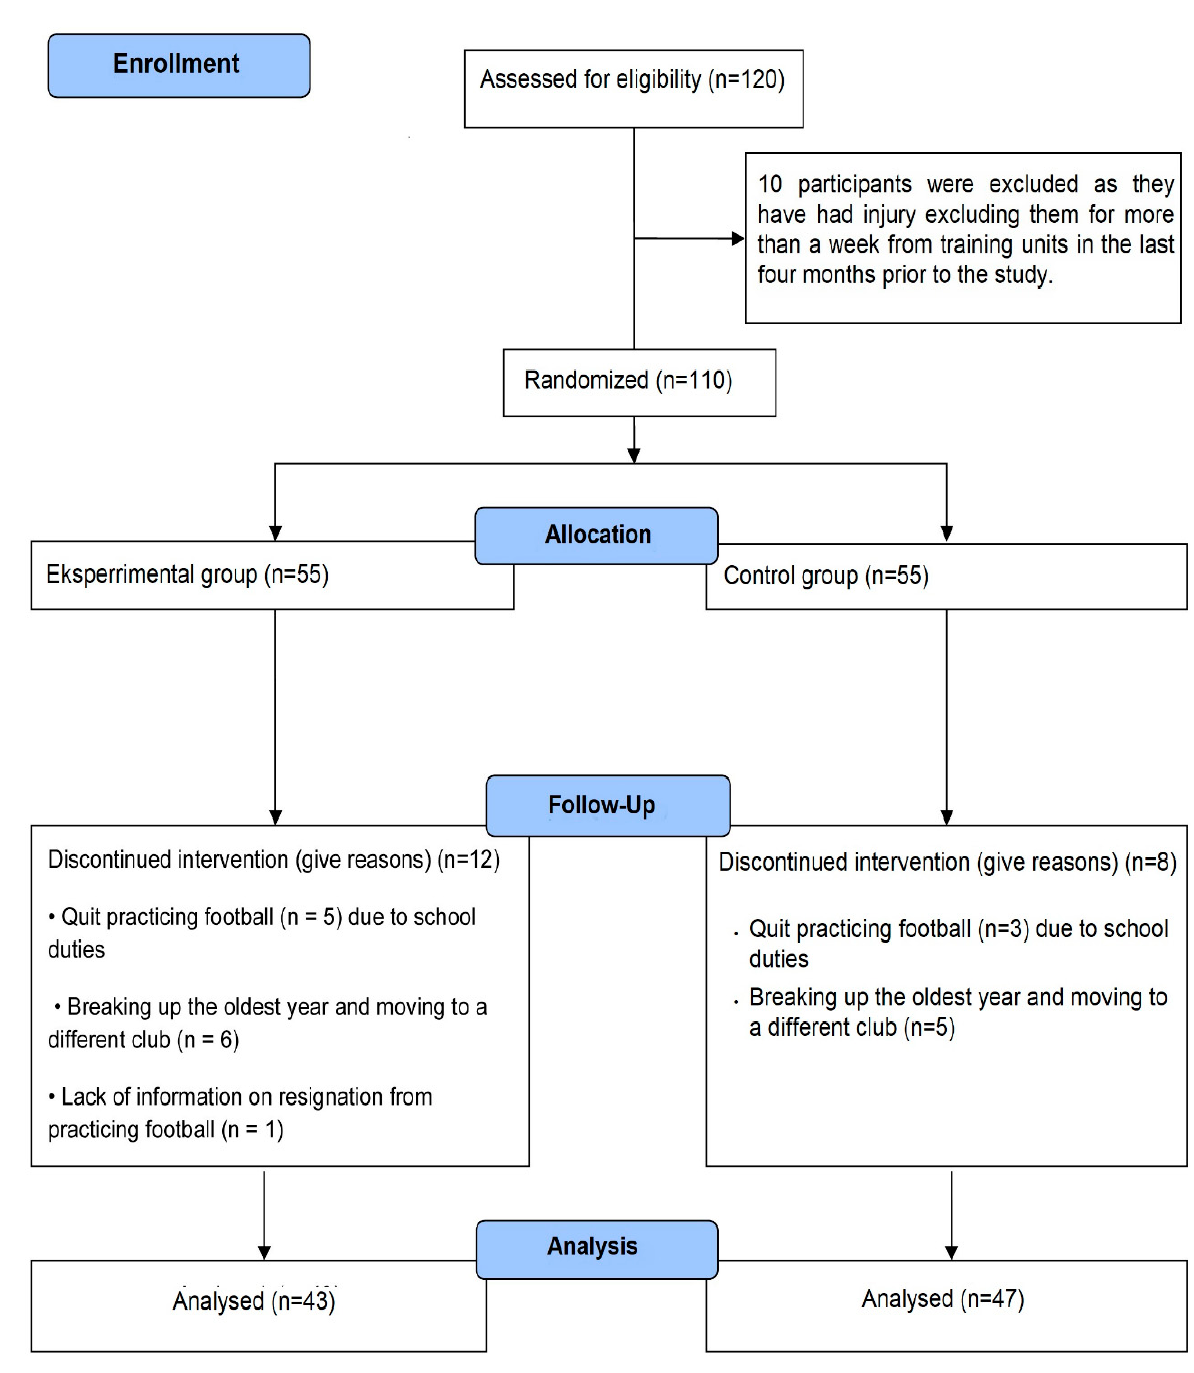
Figure 1. A detailed diagram of the flow of the studied players.